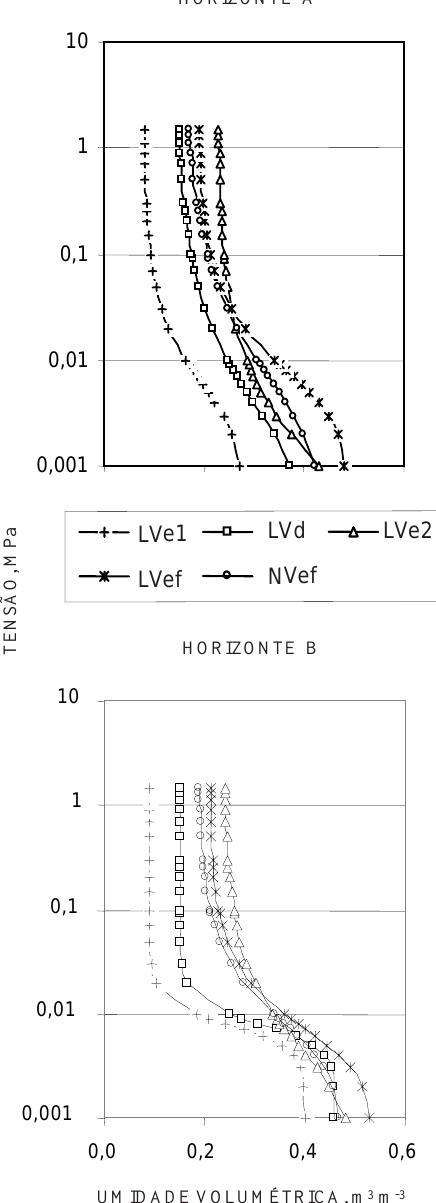
Figura 1. Curvas de retenção da água obtidas a partir de amostras dos horizontes superficiais do Ap do LVe1, LVd, LVef, NVef e A11 do LVe2 e dos horizontes subsuperficiais Bw2 do LVe1, LVd, LVe2, LVef e Bt2 do